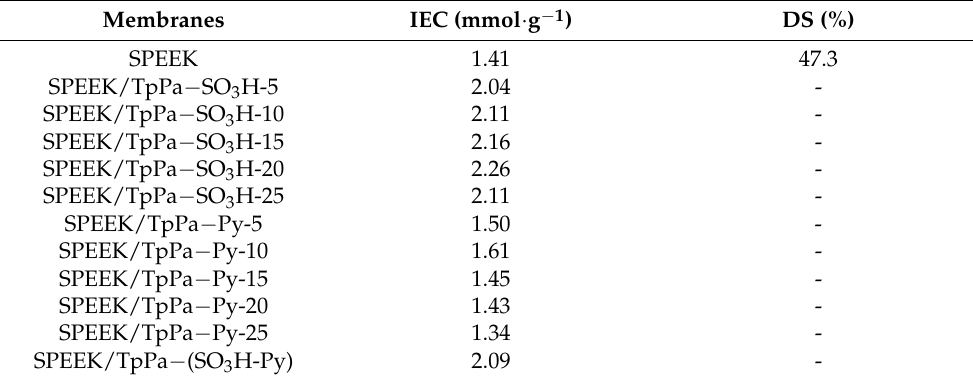
Figure 3. Proton conductivity at 60 °C, ( a , c ) 65% RH and ( b , d ) 95% RH of SPEEK, SPEEK/TpPa − SO 3 H and SPEEK/TpPa − Py. Table 1. IEC of the membranes and DS of the SPEEK.